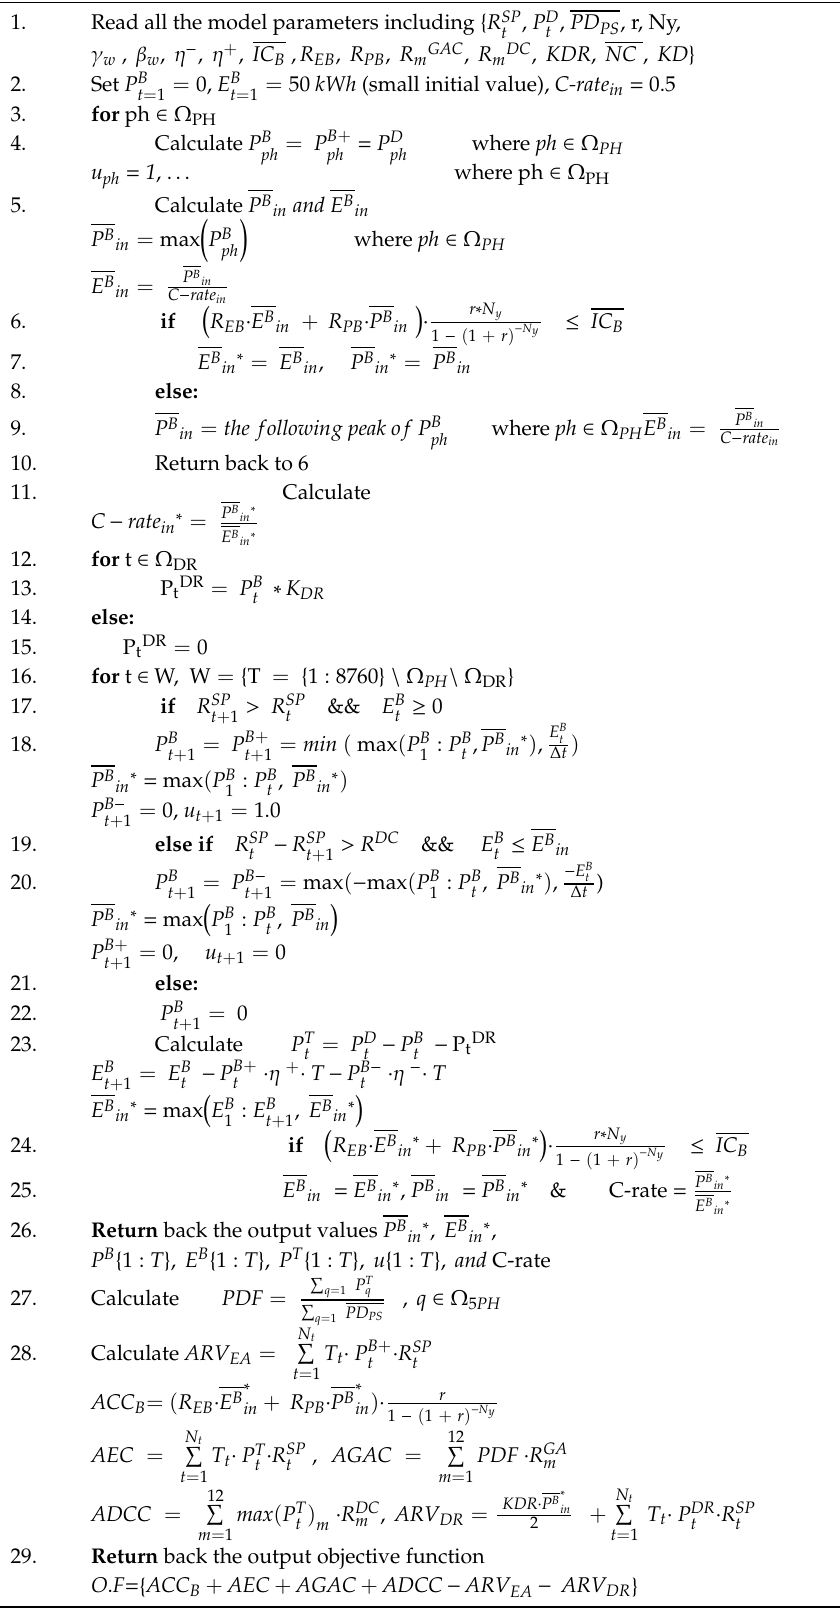
Algorithm 1 Battery storage scheduling for energy arbitrage